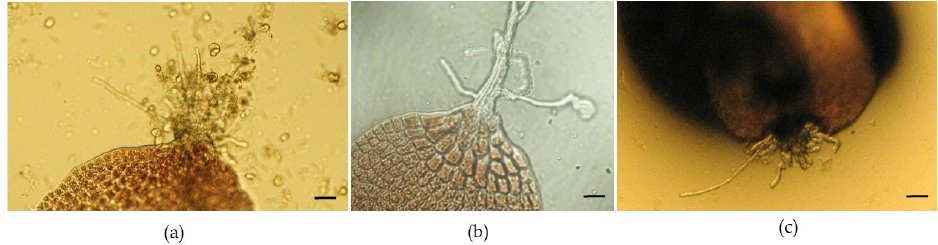
Figure 4. ( a – c ) Early stage of rhizoid development. Scale bar: 100 μ m ( a ), 50 μ m ( b ), and 200 μ m ( c ).